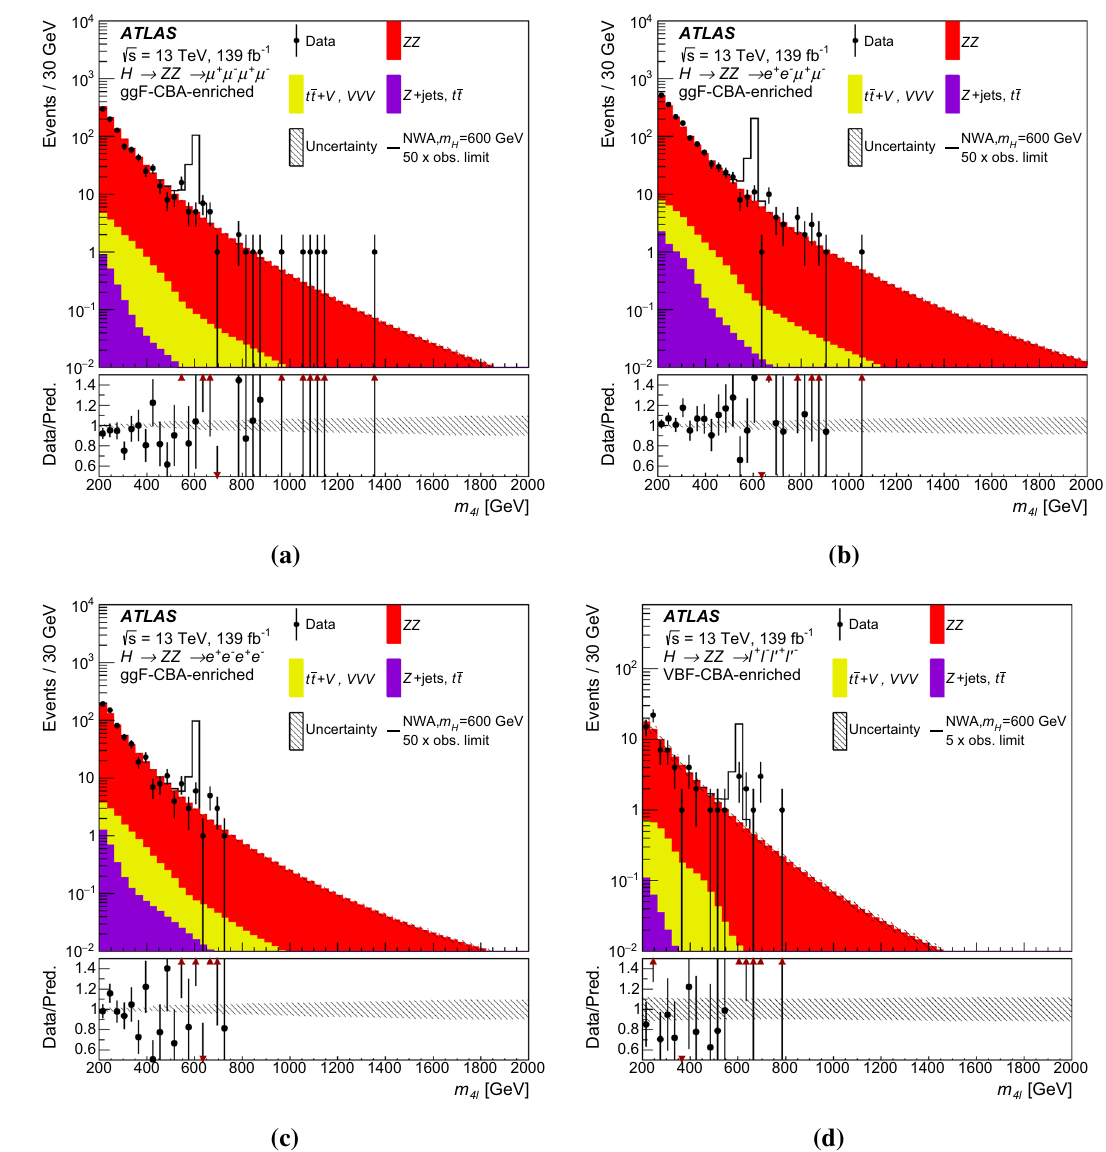
Fig. 9 Distribution of the four-lepton invariant mass m 4 (cid:3) in the (cid:3) + (cid:3) − (cid:3) (cid:2)+ (cid:3) (cid:2)− search for a , b , c the ggF-CBA-enriched categories and d the VBF-CBA-enriched category. The backgrounds are determined from a combined likelihood fit to the data under the background-only hypothesis. The simulated m H = 600 GeV signal is normalised to a